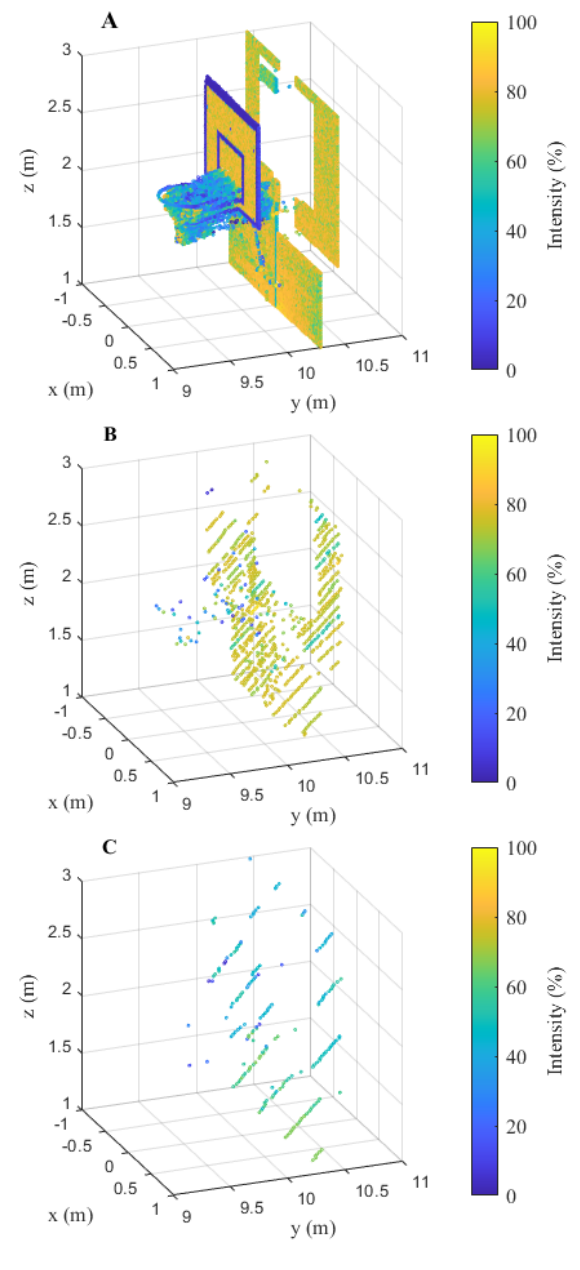
Figure 3: Lidar data comparison between Leica ScanStation P40 (A), Velodyne VLP-32C (B), and Velodyne VLP-16 Puck Lite (C). All point clouds are a single scan, collected from the same position 10 meters away from the target (a basketball